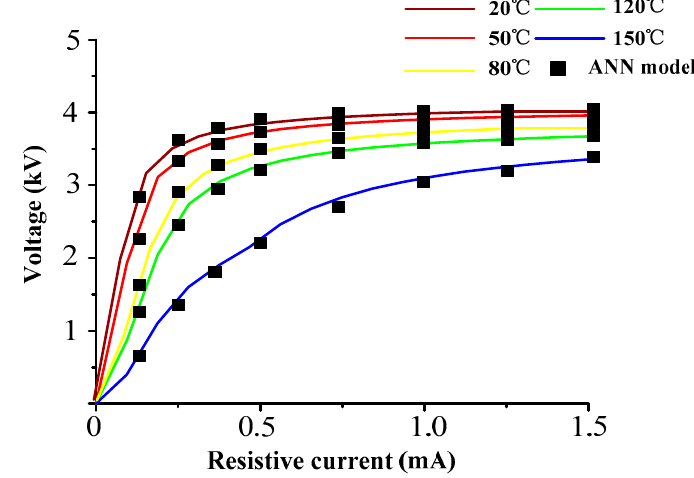
Figure 7. Comparison of V–I–T characteristics between simulated and experimental results.